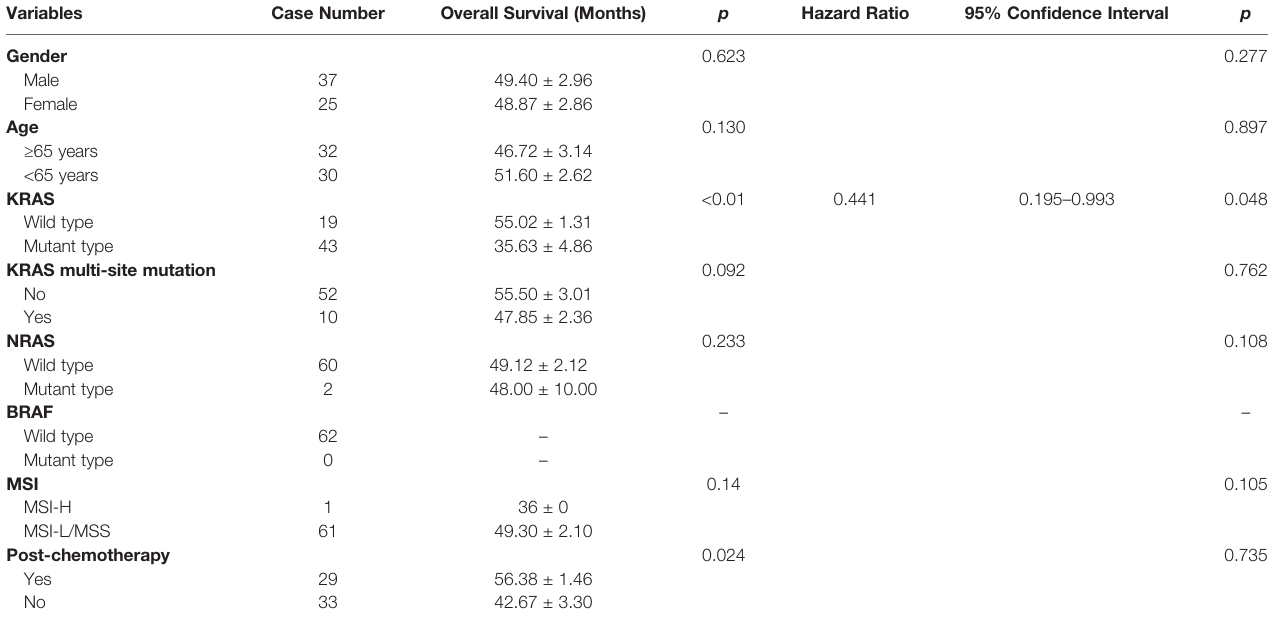
TABLE 5 | Survival analysis of